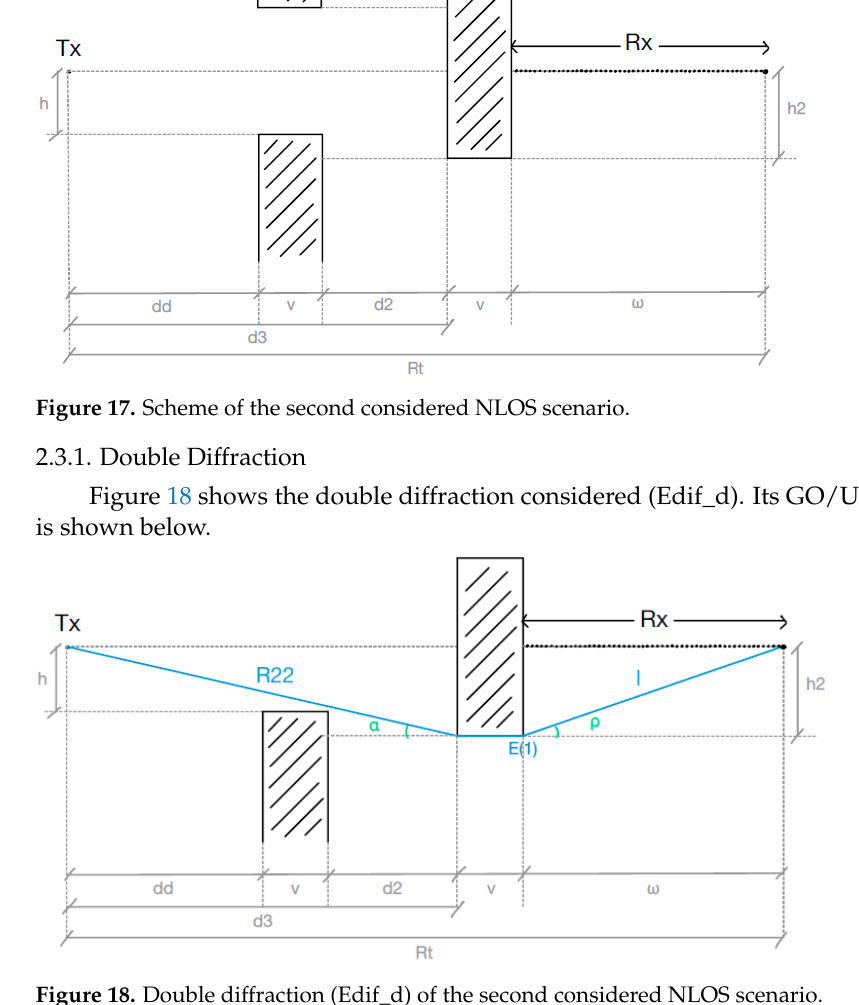
Figure 18. Double diffraction (Edif_d) of the second considered NLOS scenario.